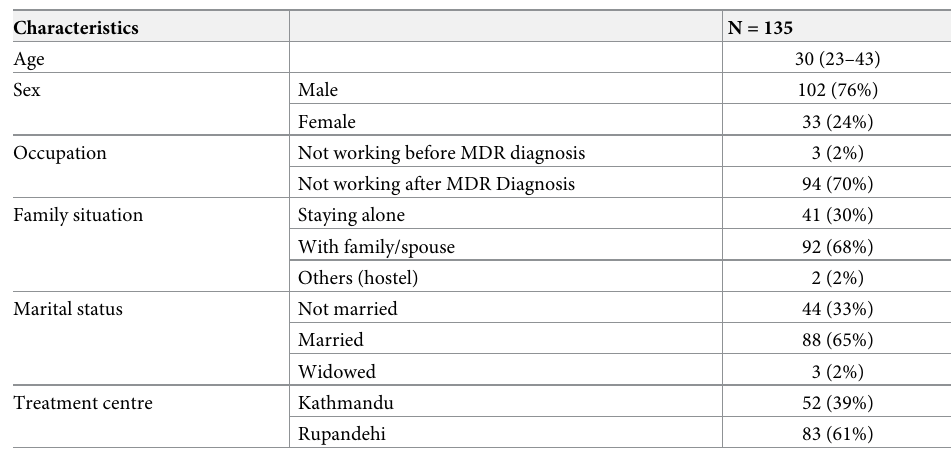
Table 1. Patient